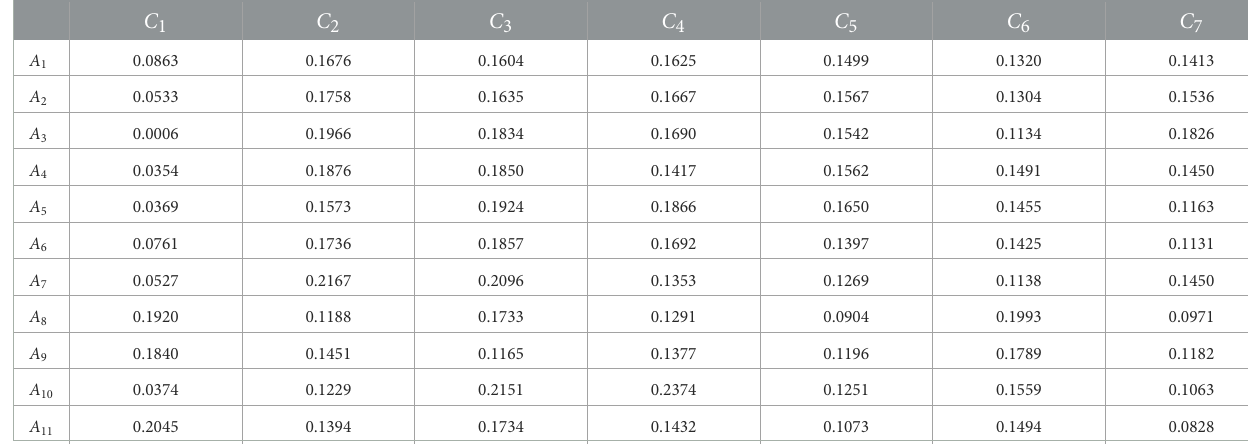
TABLE 3 Prospect theory weight of optimal reference point ω ∗ .